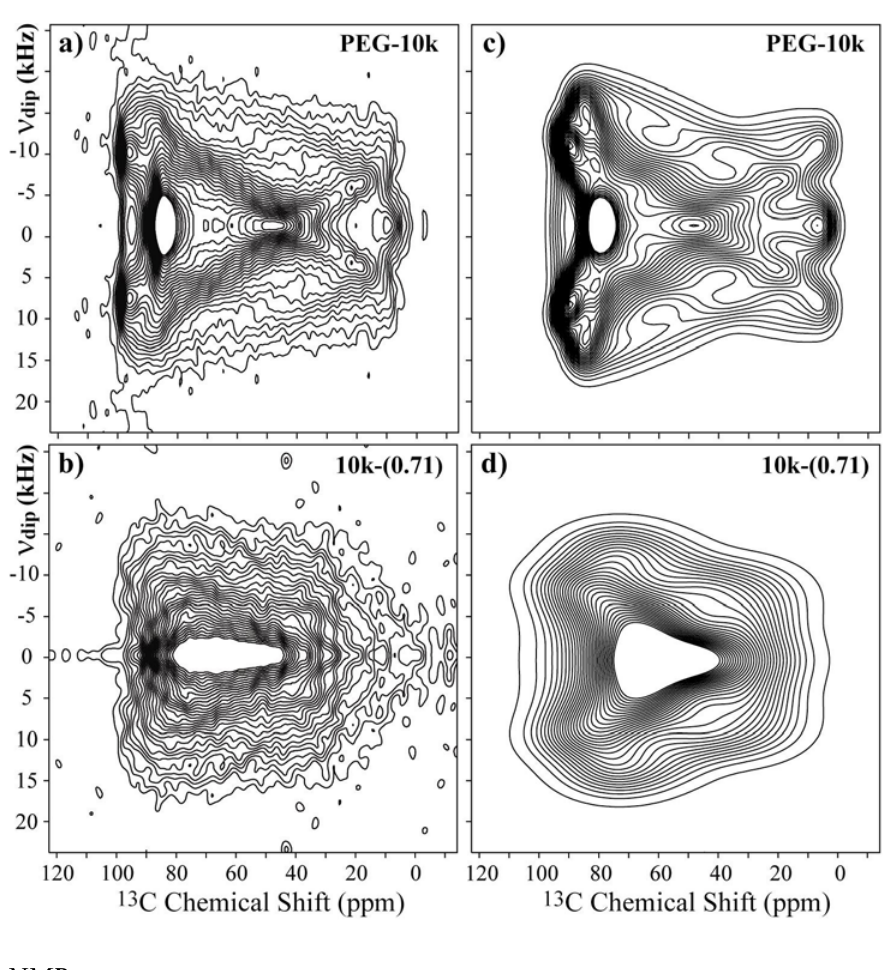
Figure 4. Experimental 2D Separated-Local-Field NMR spectra obtained for ( a ),( b ) pure PEG with M = 10,000 g/mol and the 10k-(0.71) samples at room temperature; and ( c ),( d ) w the corresponding simulations using the CSA orientation reported in reference